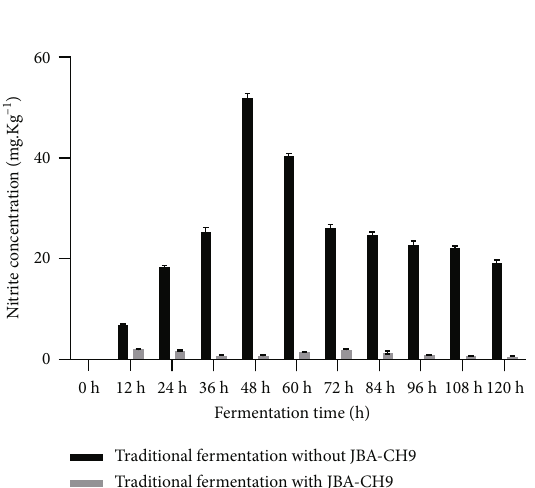
Figure 4: 3D diagram of response surface